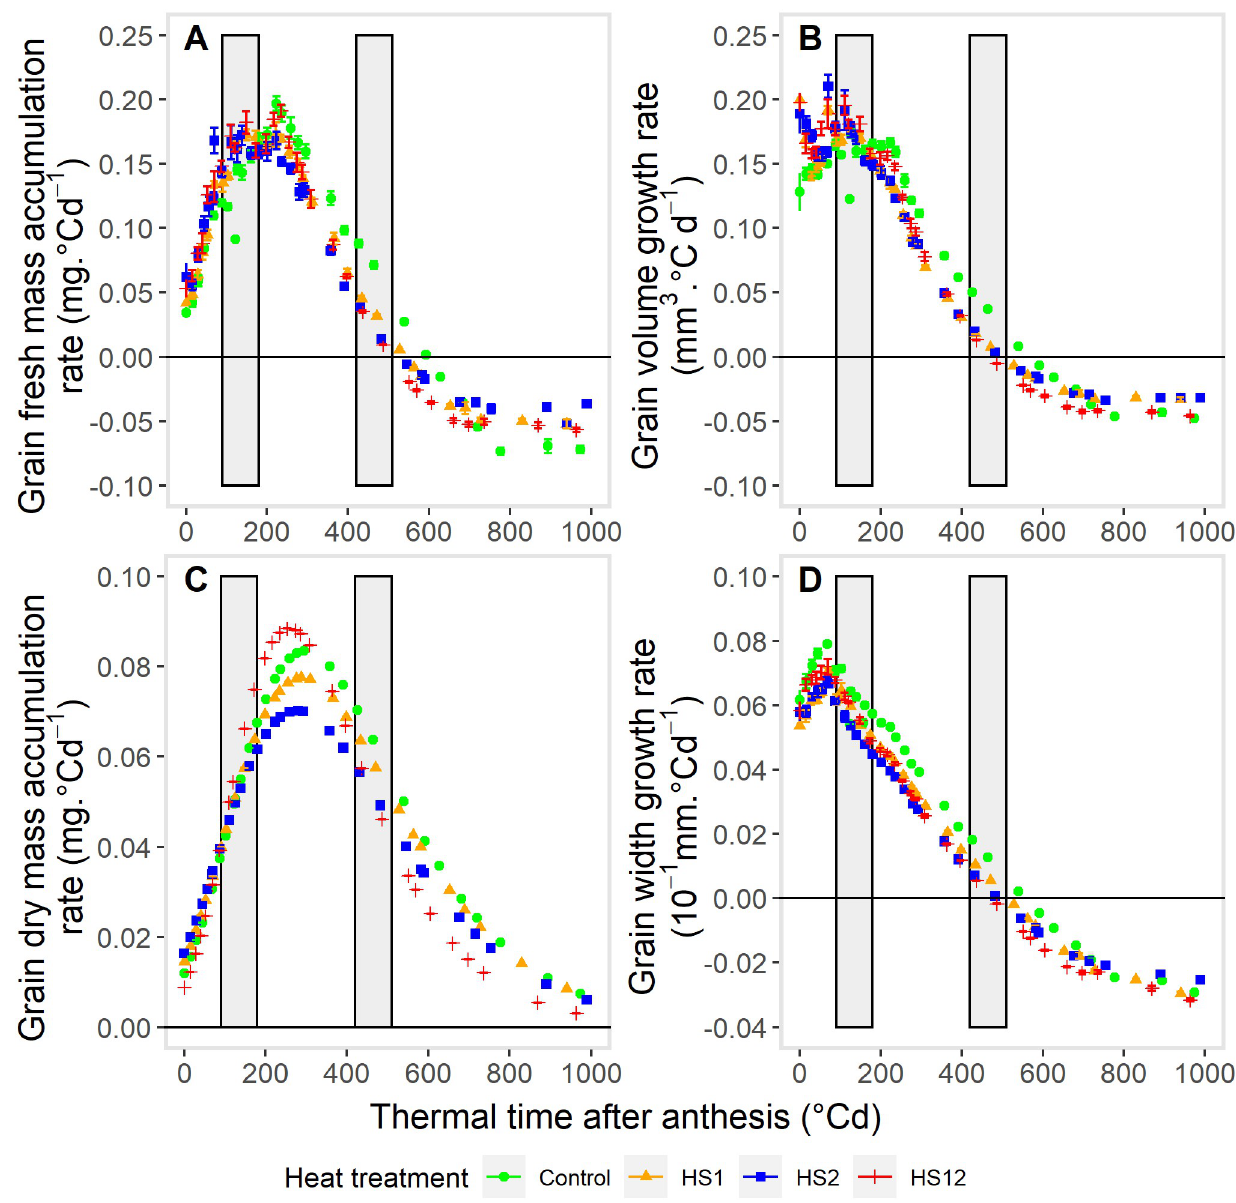
Fig 3. Effects of heat shocks on whole grain growth rates. Whole grain fresh mass accumulation rate (A), volume growth rate (B), dry mass accumulation rate (C), and width growth rate (D) during grain development after anthesis. Heat shocks (HS) were applied during the lag-phase (HS1), during the grain filling-phase (HS2) or during both the lag-phase and filling-phase (HS12) of the grain development, compared to Control. Each point corresponds to the values estimated from the derivative of the fitted growth functions (S2 Table). Vertical grey bars indicate the times and duration of exposure to heat shocks (~90˚Cd and ~420˚Cd after anthesis for respectively HS1 and HS2 during 4 days